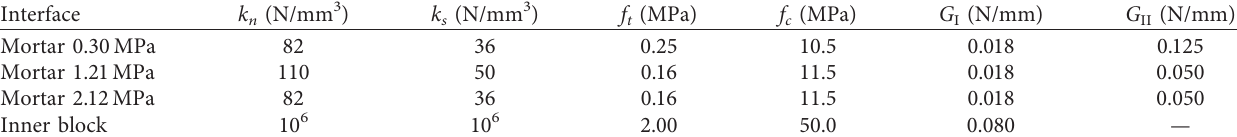
Table 1: Mechanical properties of mortar joints and inner block joints of the case studies considered.